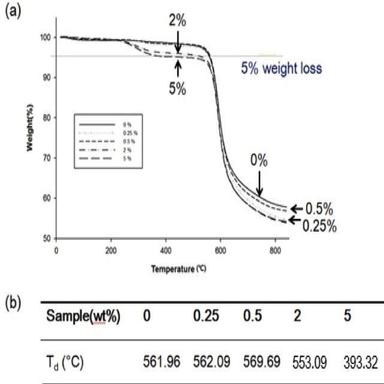
(a) Thermogram of PI films at different catalyst amounts (wt%), and (b) Thermal degradation temperature (Td) of PI films at different catalyst amounts (wt%). Here, the final curing temperature was 350 °C for.10 min.